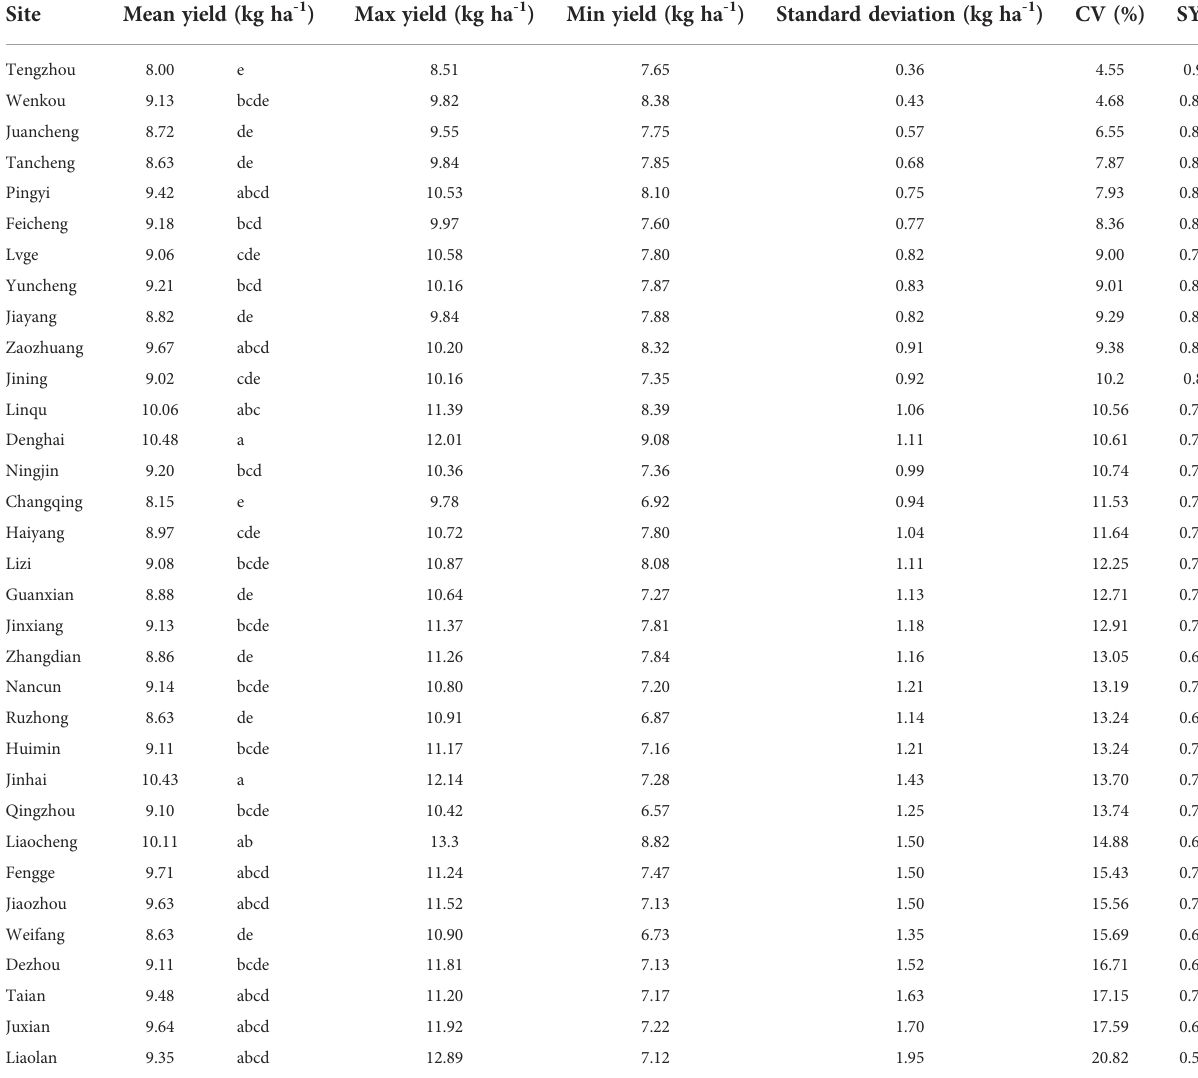
Symbols not sharing any lowercase letters are signi fi cantly different at the level of p <